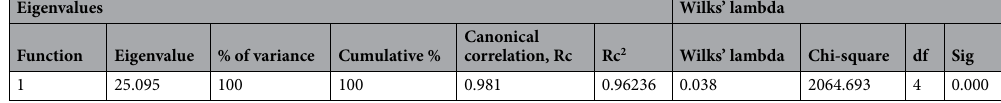
Eigenvalues Wilks’ lambda Function